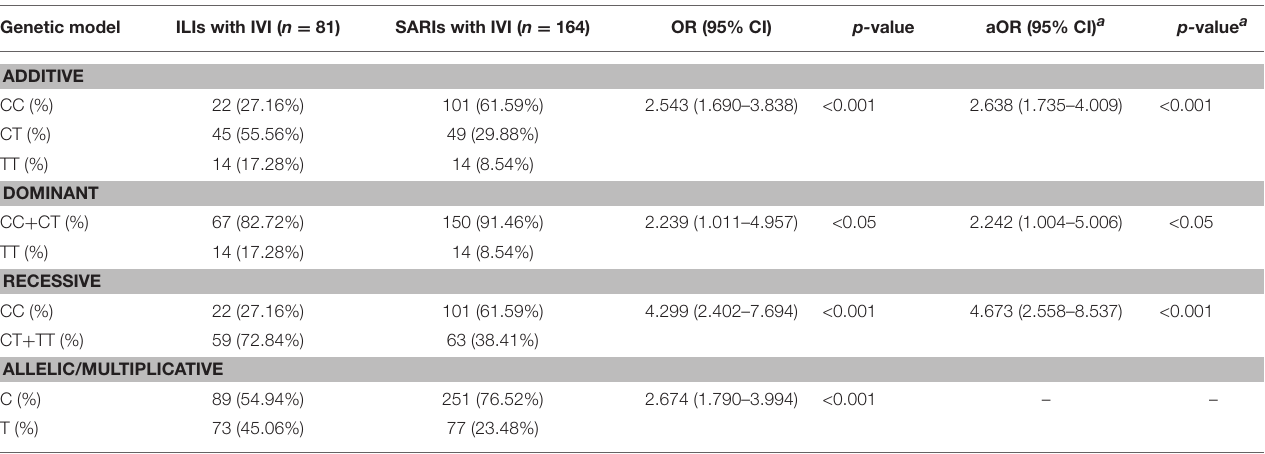
TABLE 2 | Risk assessment for rs12252 genotype using different